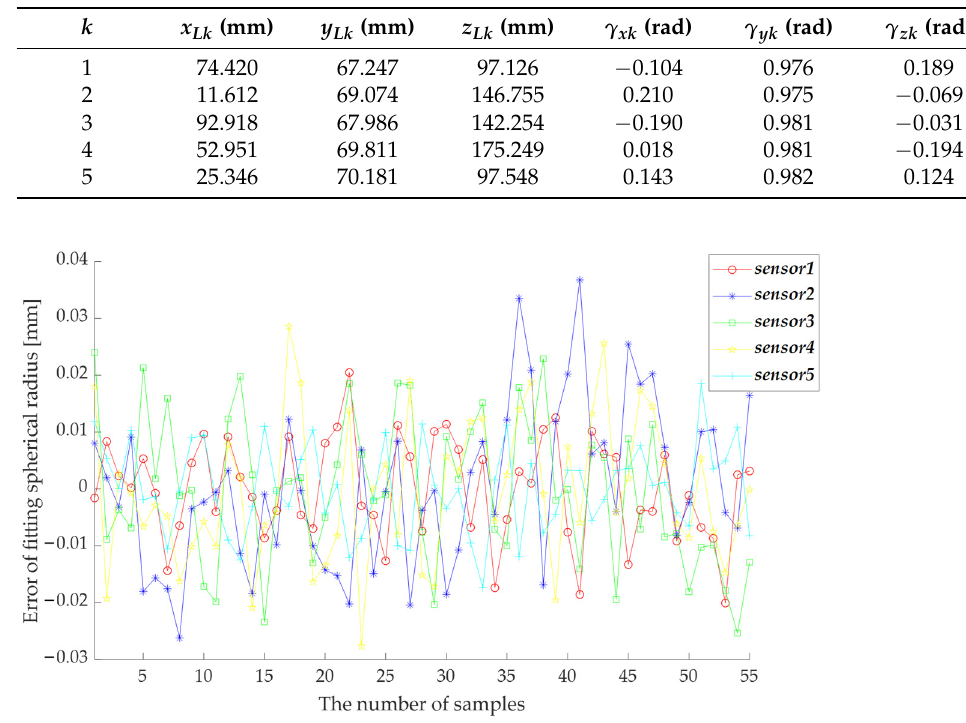
Figure 6. The measuring errors of SPMS. Table 3. The statistics information of the measuring errors. Index